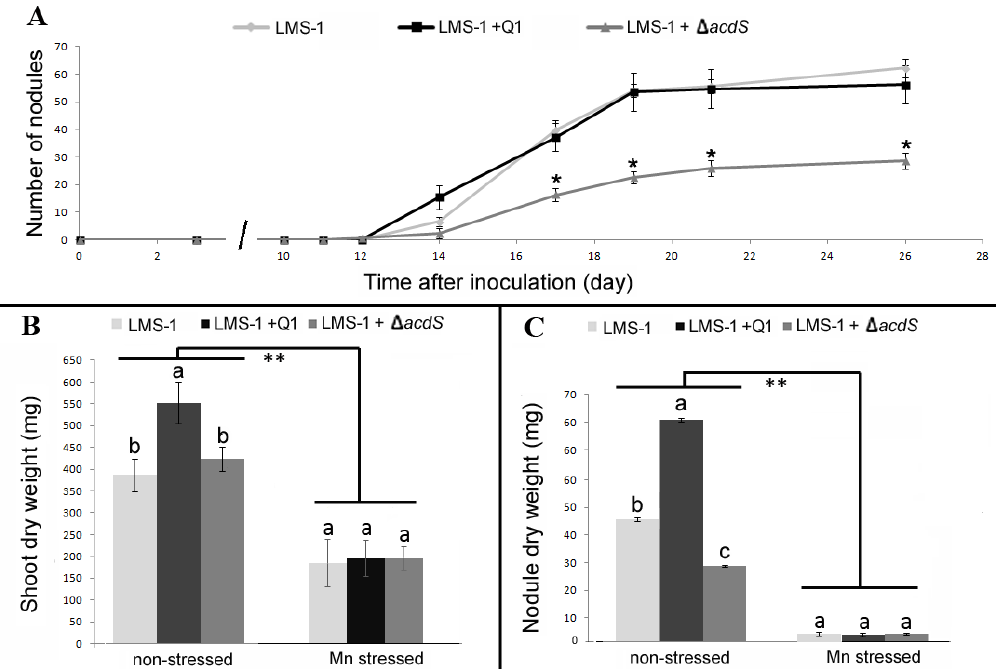
Figure 4. Nodulation kinetics by a hydroponic assay of chickpea plants single inoculated ( M. ciceri LMS-1 (LMS-1)) and co-inoculated ( M. ciceri LMS-1 and Pseudomonas sp . Q1 (LMS-1 + Q1) or M. ciceri LMS-1 and Pseudomonas sp . Q1 ∆ acdS mutant (LMS-1 + Δ acdS )). ( A ) Nodulation kinetics of chickpea plants during 26 days at non-stressed conditions. Each point represents the mean and standard error values of eight plants per treatment. The asterisks correspond to significant di ff erences between the LMS-1 + Q1 ∆ acdS treatment and the other two treatments. ( B ) Shoot dry weight at the end of the hydroponic assay ( C ) Nodule dry weight at the end of the hydroponic assay. Di ff erent letters (a–c) correspond to statistically significant di ff erences ( p < 0.05) within each group (non-stressed and Mn stressed). * denotes statistically significant di ff erences between the treatments means in the presence and absence of high Mn concentration (** p <